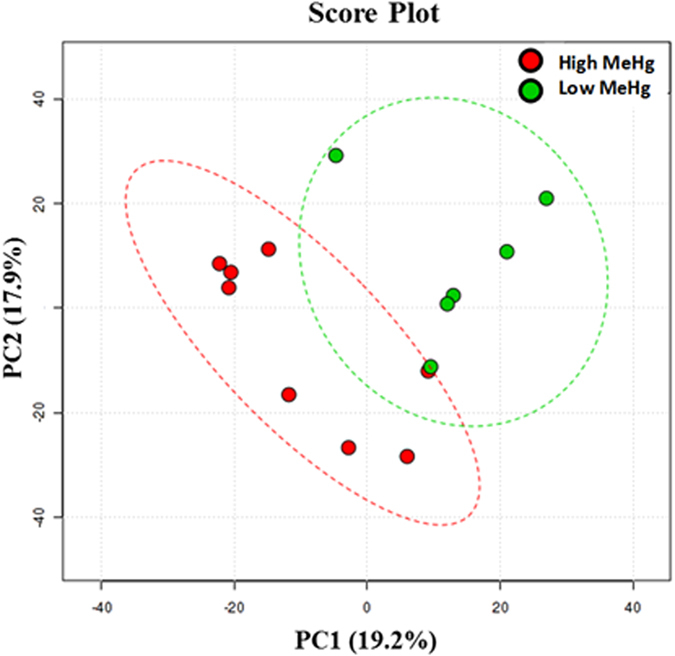
Microbial diversity at genus level reveals hierarchical partitioning of high and low MeHg DWW samples.Bacterial communities were clustered using partial least squares-discriminant analysis (PLS-DA). Red circles represent samples with high methyl Hg levels and green circles represent samples with low methyl Hg.